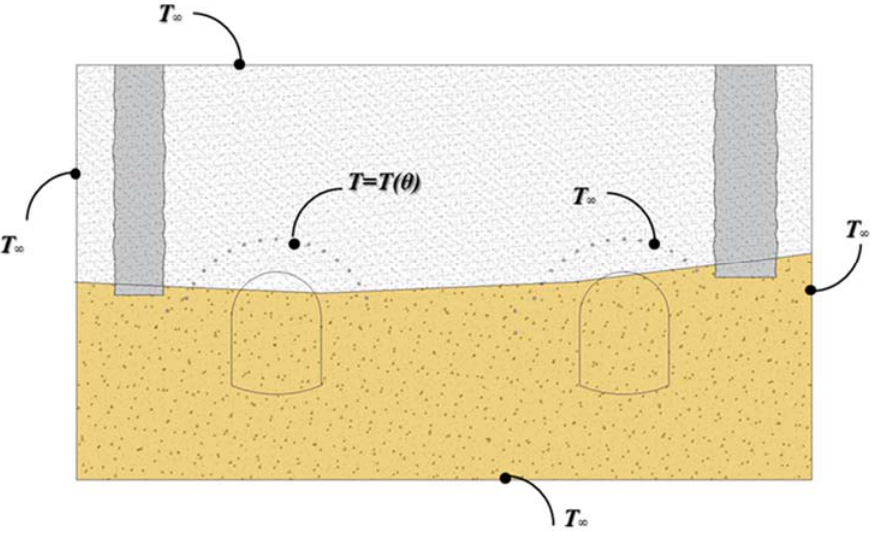
Figure 7. Computational domain and boundary conditions before the excavation.